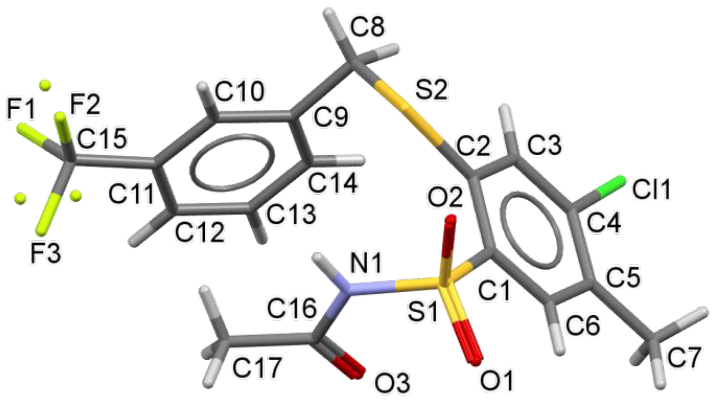
Figure 3. Atom numbering scheme for 22 , hydrogen atoms not labelled for clarity. Less populated fluorine atoms in disordered part of –CF 3 shown as small, disconnected balls. Selected bond lengths [Å] and angles [°]: S1-O1 1.438(2), S1-O2 1.430(2), S1-N1 1.649(3), S1 C1 1.775(2), N1-C16 1.400(4), C16-O3 1.211(4), S2-C2 1.787(3), S2-C8 1.836(3); O1-S1-O2 119.3(1), O1-S1-N1 109.0(1), O2-S1-N1 105.0(1), C2-S2-C8 103.4(1), S1-N1-C16 124.6(2),